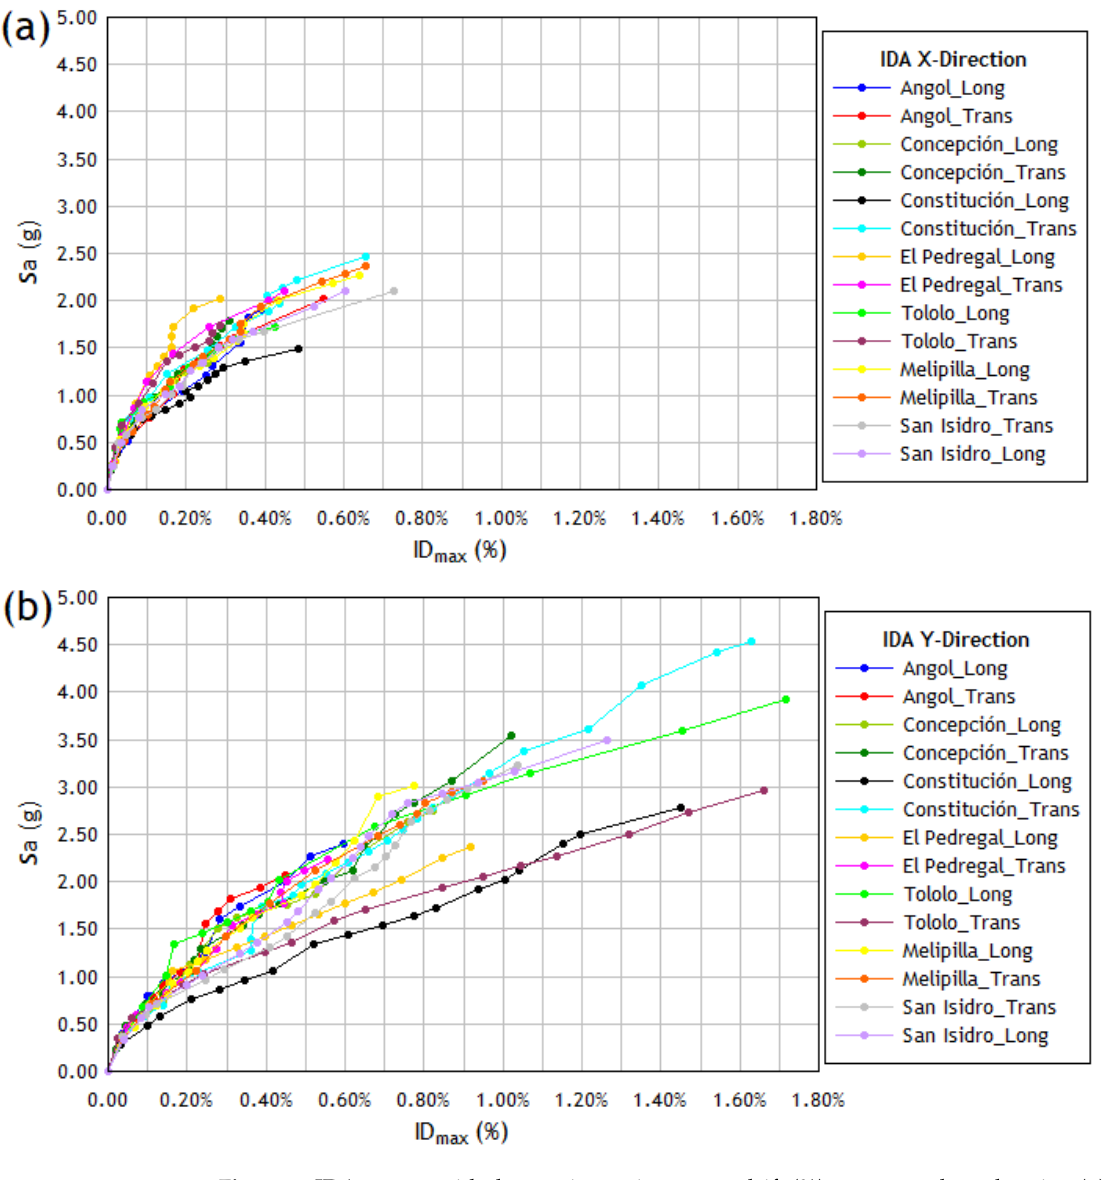
Figure 6. IDA curves with the maximum interstory drift (%) vs. spectral acceleration (g) obtained for the structural model ( a ) in the X direction and ( b ) in the Y direction, under the action of the 14 seismic records considered in the study.